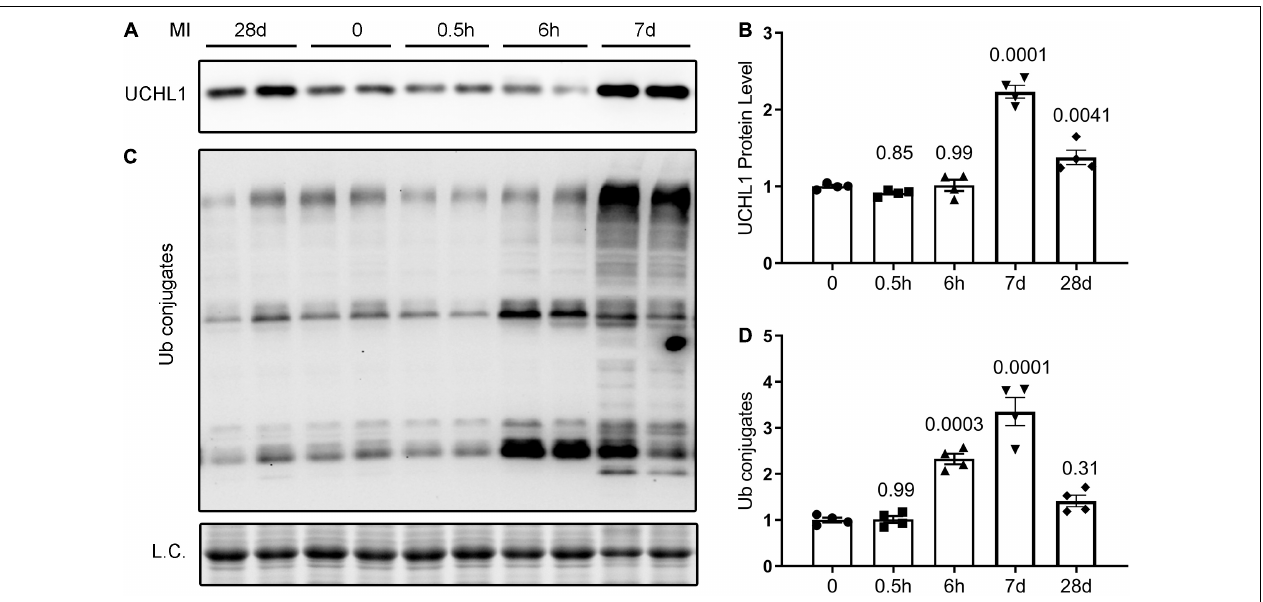
FIGURE 1 | Dynamic changes in myocardial UCHL1 protein levels and ubiquitin (Ub) conjugates in post-MI mice. Female wild type mice were subjected to sham surgery or the ligation of the left anterior descending artery (LAD) to induce myocardial infarction (MI). Ventricular myocardium from the non-infarct area (peri-infarct plus remote area) were collected from the sham (0) and the MI mice at the indicated post-MI time points for total protein extraction. Representative images (A) and pooled densitometry data (B) of Western blot analyses for UCHL1. Representative images (C) and pooled densitometry data (D) of Western blot analyses for total Ub conjugates. L.C., loading control, which used the images from staining-free gel imaging technology; h, hour(s) post-MI; d, days post-MI; n = 4 mice per group; the p -value shown above each post-MI time point is derived from the pair-wise comparison between the post-MI time point and the sham control; one-way ANOVA followed by Tukey’s